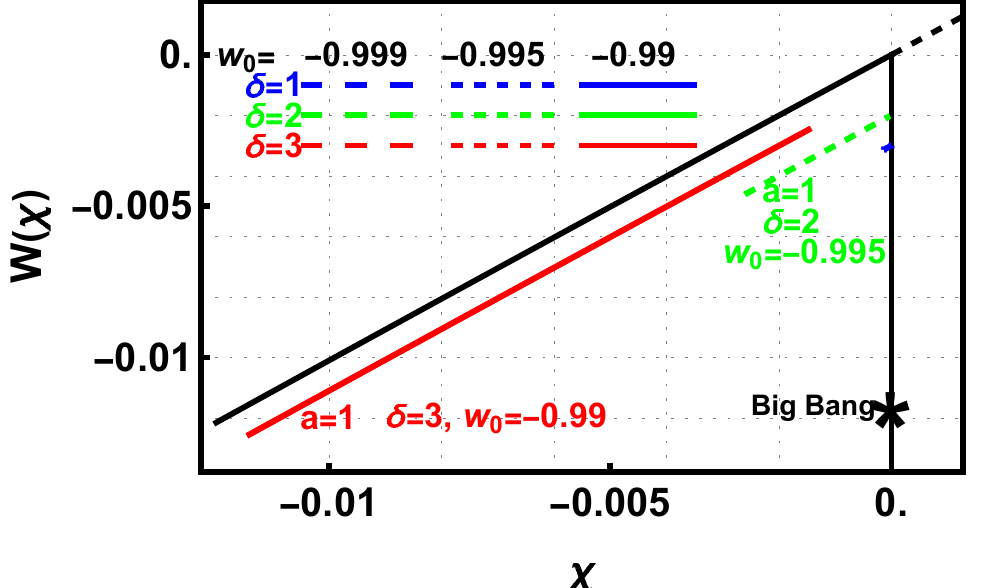
Figure 3. The figure shows the region between the Big Bang and the furthest evolution of any of the cases in this study. This figure initiates a code continued throughout the paper. The δ = 1, 2 and three cases are displayed in red, green, and blue. The w 0 = − 0.99, − 0.995, and − 0.999 cases are displayed with solid, dashed, and long dashed line styles as shown in the upper left of the figure. The figure is an expanded view of the region between the thin black vertical line and the thick dashed line in Figure 2. In this figure, the Big Bang is the black vertical line marked with an asterisk near the bottom. The right and left ends of the evolutions are the start point at a = 0.1 and the end point at a = 1.0, respectively. Further discussion of the figure is in the text. The black sloped solid and dashed line is the same as in Figure 2 for the small expanded region. The red solid and green dashed line are the evolutions of the δ = 3, w 0 = − 0.99, and the δ = 2, w 0 = 0.995 cases. The long dashed blue evolution for the δ = 1 w 0 = −